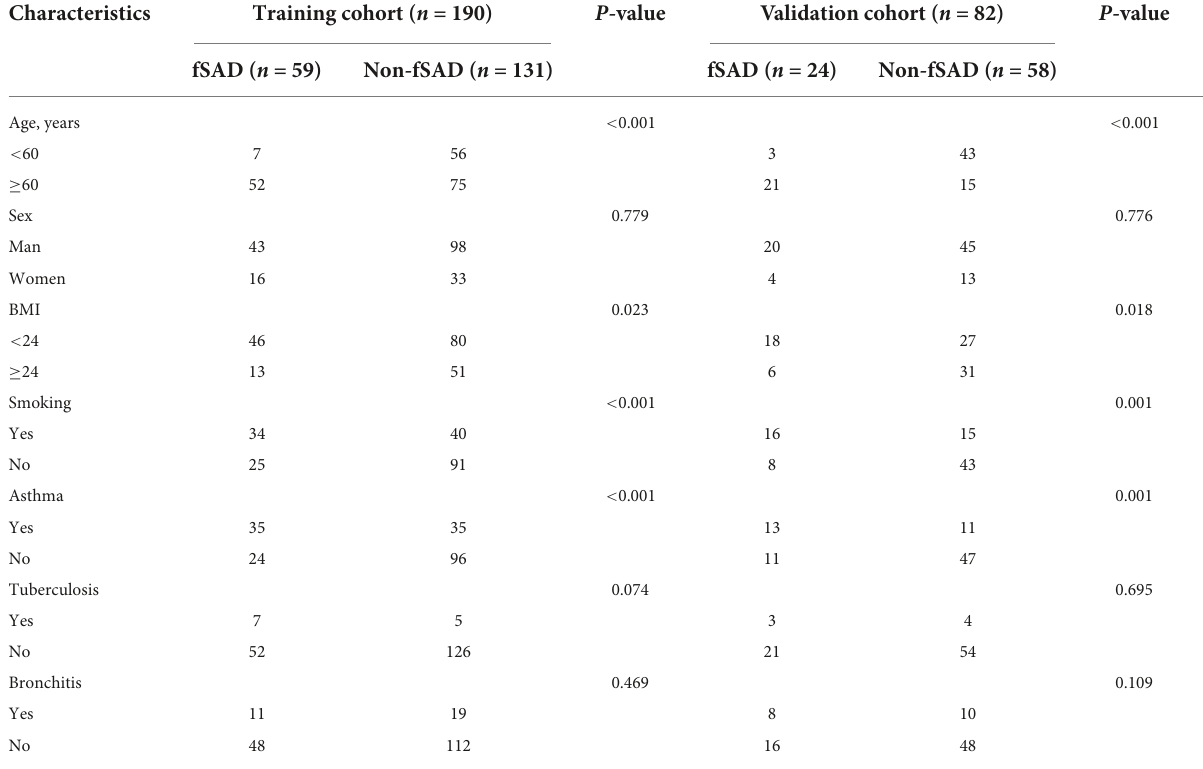
TABLE 1 Preoperative clinical characteristics of patients with or without fSAD.